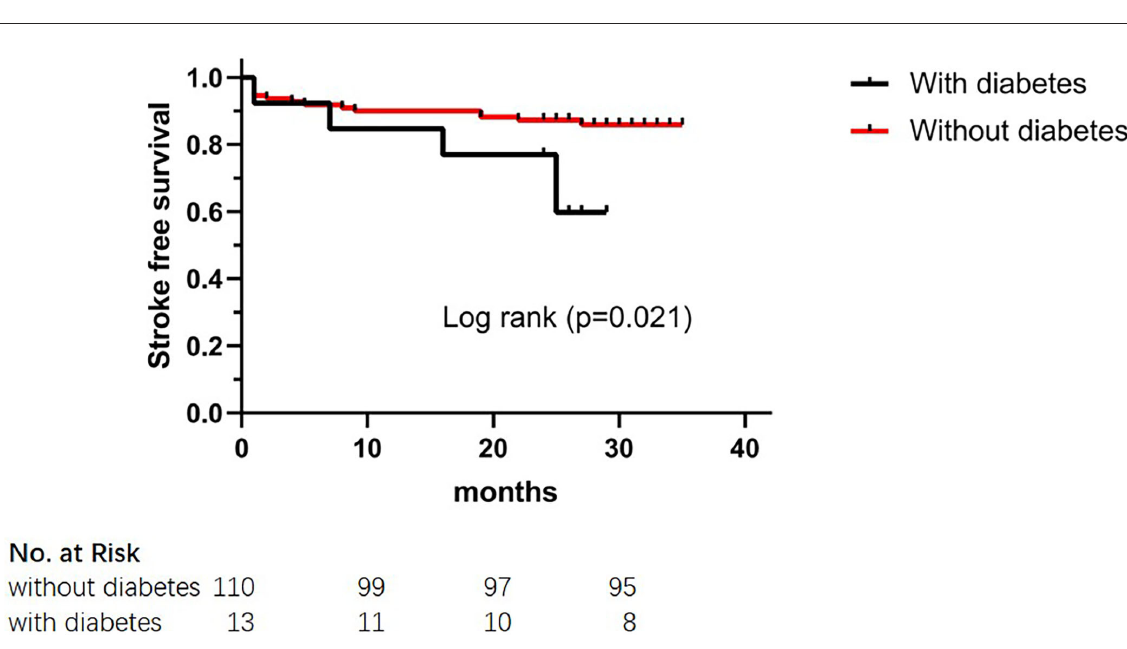
of several years (14). In this study, we also found that HHDL was remarkably associated with a higher risk of recurrent stroke during the long-term follow-up in patients with